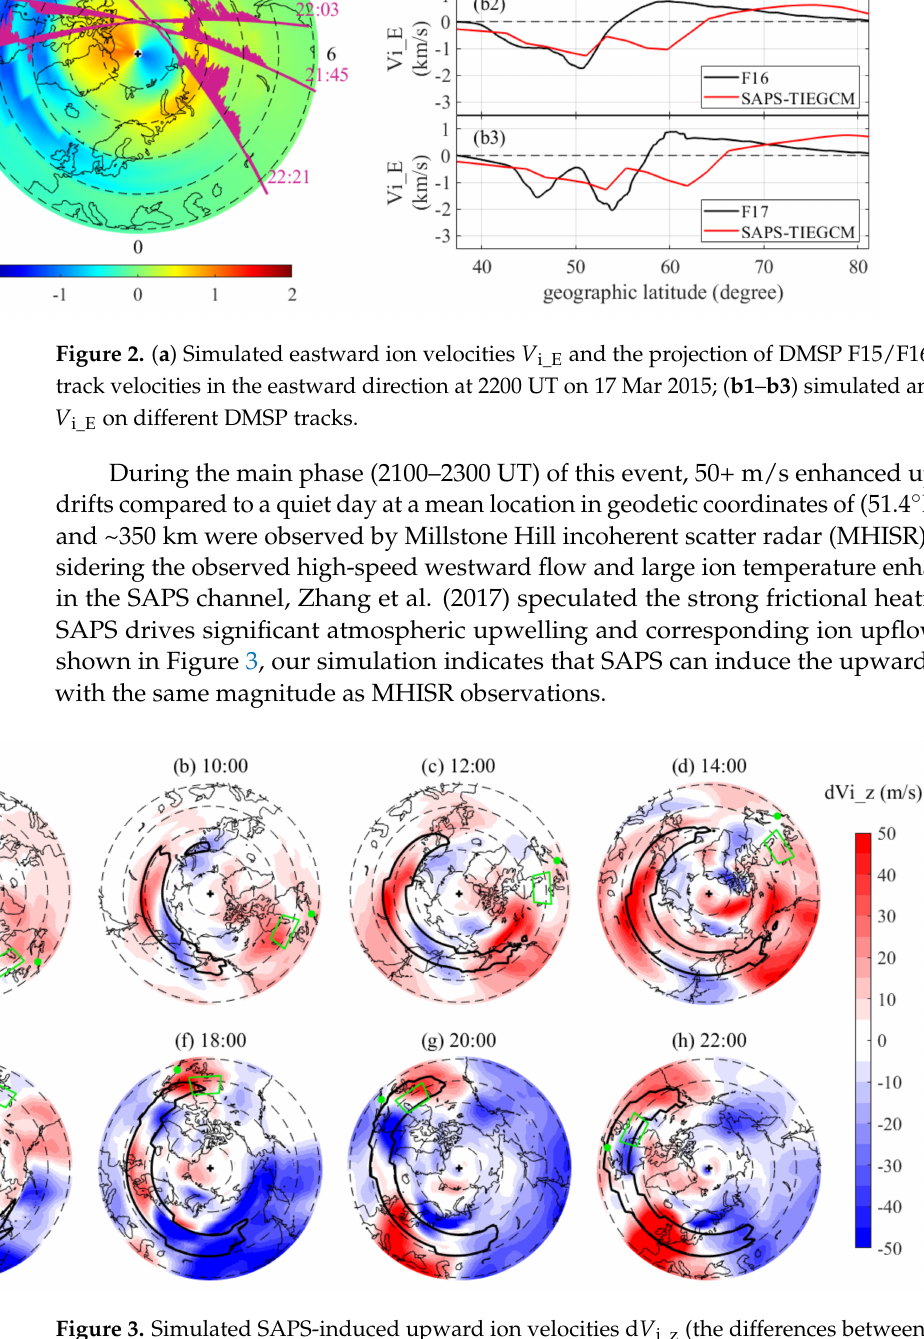
Figure 3. Simulated SAPS-induced upward ion velocities d V i_z (the differences between the simula- tion results from TIEGCM with and without the SAPS model) at ~350 km at different UTs. The black contour lines are SAPS channels with V i_E = − 200 m/s. The green points and boxes are the locations of MHISR and its approximate field of view,